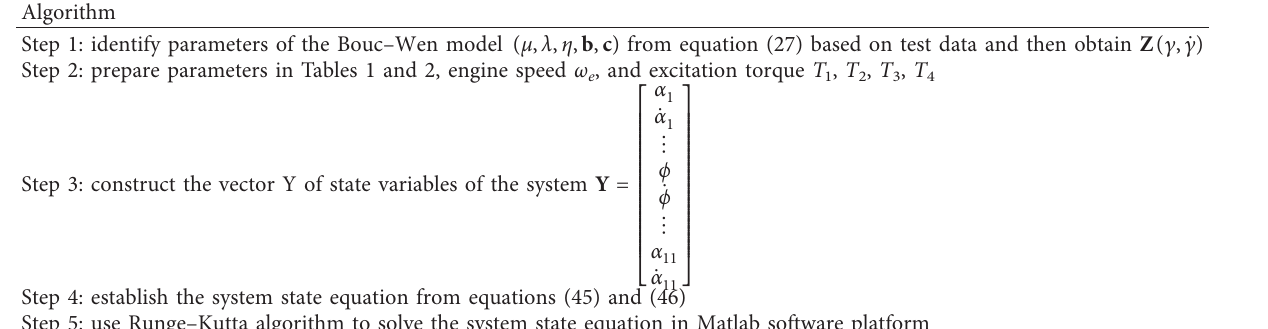
Table 3: Simulation